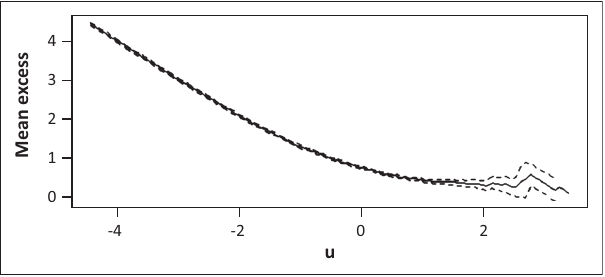
FIGURE 4: Mean excess plot of asymmetric power auto-regressive conditional heteroscedastic (1,1) model (normal innovations)